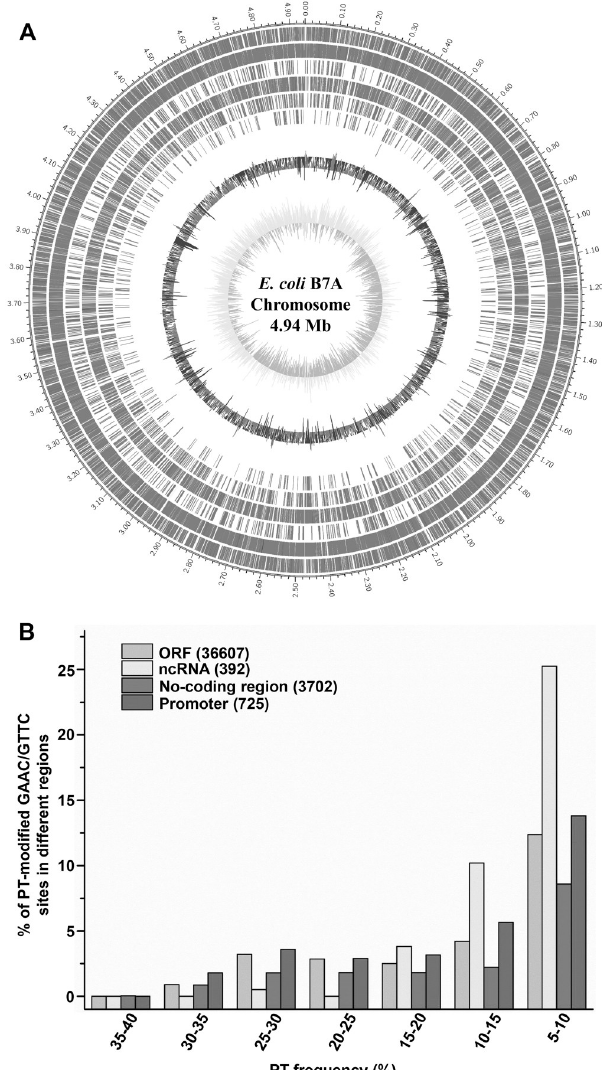
Fig 4. The distribution analysis of PT sites with different modification frequency. (A) PT site mapping across the E . coli B7A genome. From outer to inner circles: 1 to 7 (PT sites modified with 5%-10%, 10%-15%, 15%-20%, 20%-25%, 25%-30%, 30%-35%, 35%-40%): PT sites in ORFs (grey), in rRNA(yellow), tRNA (blue) and non-coding regions (red); 8: GC content; 9: GC skew. (B) The distribution analysis of PT modification frequency for GAAC/GTTC sites at different region in the